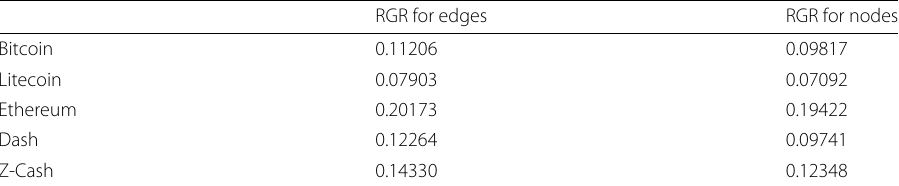
Table 2 Relative growth rate for number of edges and nodes in CMTG graph RGR for edges RGR for nodes